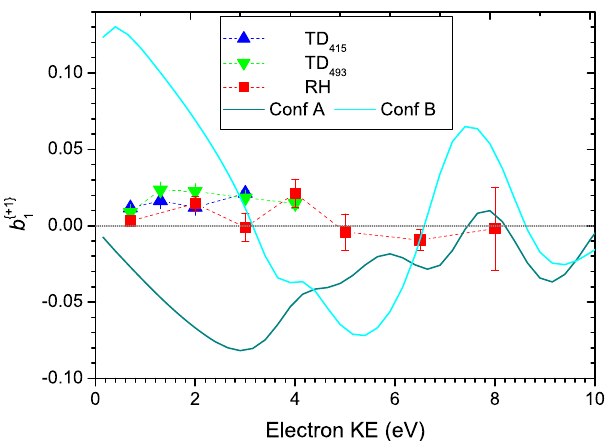
Fig. 8 Conformer Type II (A + B) mean experimental b fþ 1 g values for the 1 HOMO orbital photoionization as a function of electron KE. The data are extracted from total (parent + fragment) mass- fi ltered TD 415 , TD 495 , RH data sets using a gaussian sampling function centered at 9.65 eV binding energy. The mean experimental b þ 1 ð Þ data points are plotted at their central 1 sampling energy for L -Pro, with any D -Pro data negated prior to plotting. Error bars correspond to statistical (standard deviation) errors. Broken lines joining data points are to guide the eye only. CMS-X α calculations for conformers A and B are shown as solid